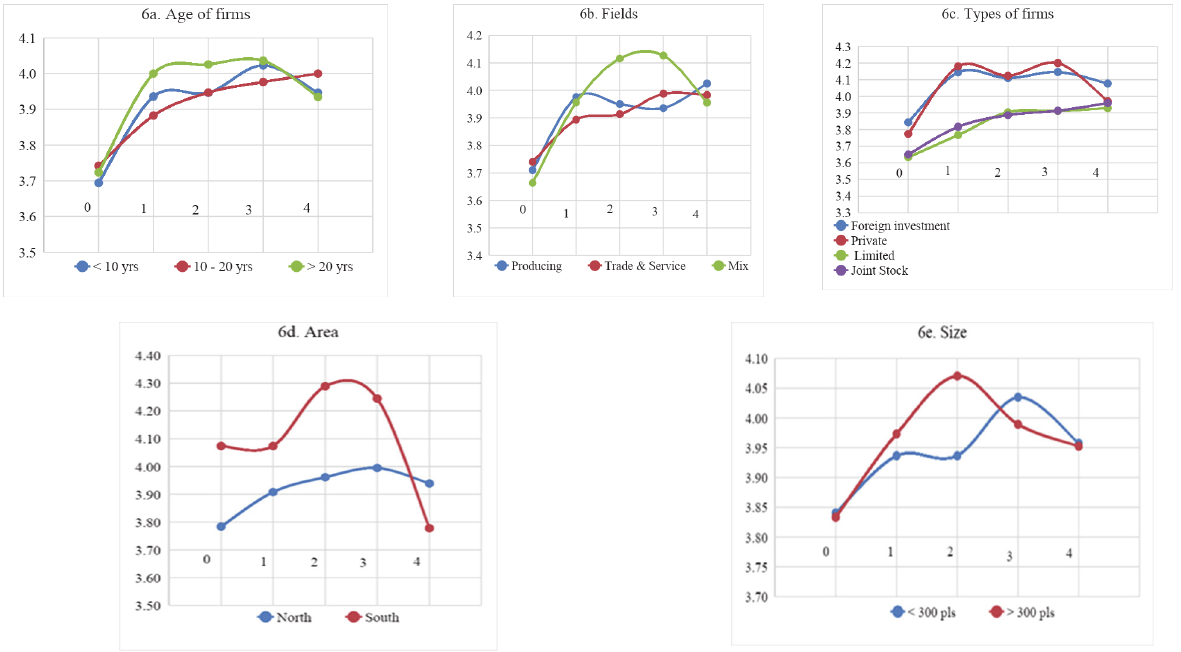
Fig. 6. Enterprise characteristics comparison (Source: Authors synthesized on the basis of research